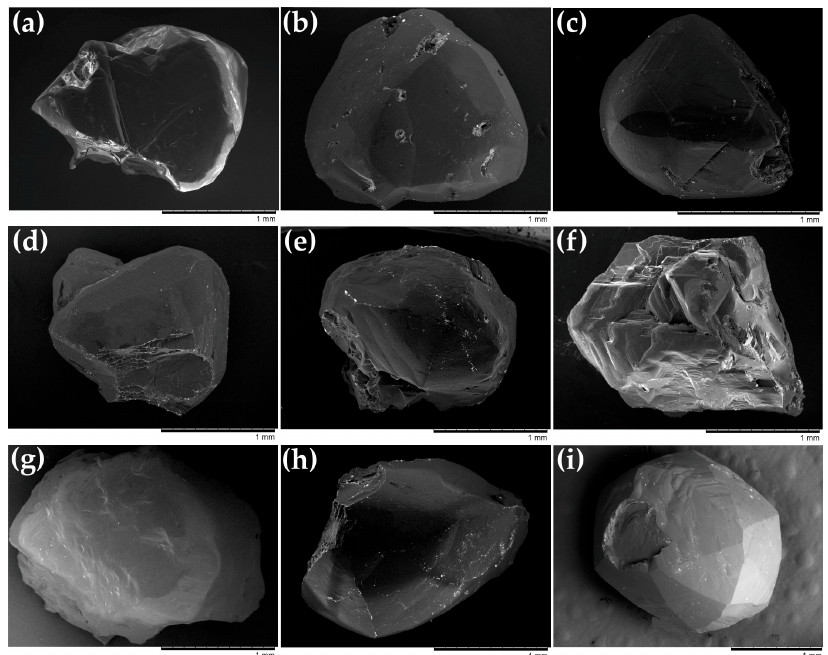
Figure 3. Morphology of studied super-deep diamonds (backscattered electron image). ( a ) SL-34; ( b ) SL-52; ( c ) SL-55; ( d ) SL-16; ( e ) SL-2; ( f ) SL-24; ( g ) C-2; ( h ) SL-82; ( i ) HH-11. ( a – h ) super-deep diamonds from São-Luiz alluvial placers (Juina, Brazil); (i) super-deep diamond crystal from Kholomolokh placer (Yakutia, Russia).